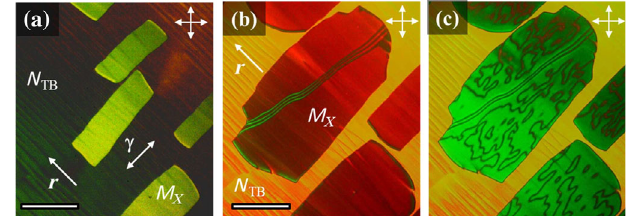
FIG. 4. Coexistence of uniform single domains of the M and X N phases of the BP12 mixture (planar cell, d ¼ 9 . 8 μ m, scale TB bar 100 μ m). The optic axes of both phases are approximately parallel to the rubbing direction r . The cell is viewed between crossed polarizers, using a Berek compensator with slow axis γ ⊥ r . (a) Growth of uniform M domains within the N at X TB T ¼ 102 . 4 °C. (b),(c) M and N domains at T ¼ 100 . 7 °C, X TB without a field (b) and when a biaxial Fr´eedericksz transition ¼ 9 V, f ¼ 6 kHz) applied (c) is induced by an ac field ( U rms along the cell normal. The birefringence of the N [yellow TB regions in (b) and (c)] is independent of the field. The birefrin- gence of the M phase varies with the field, from its low zero- X field value [brown-red domains in (b)] to a high value above the transition [green domains in (c)]. The defect walls that separate the twin domains in (c) appear as thick dark